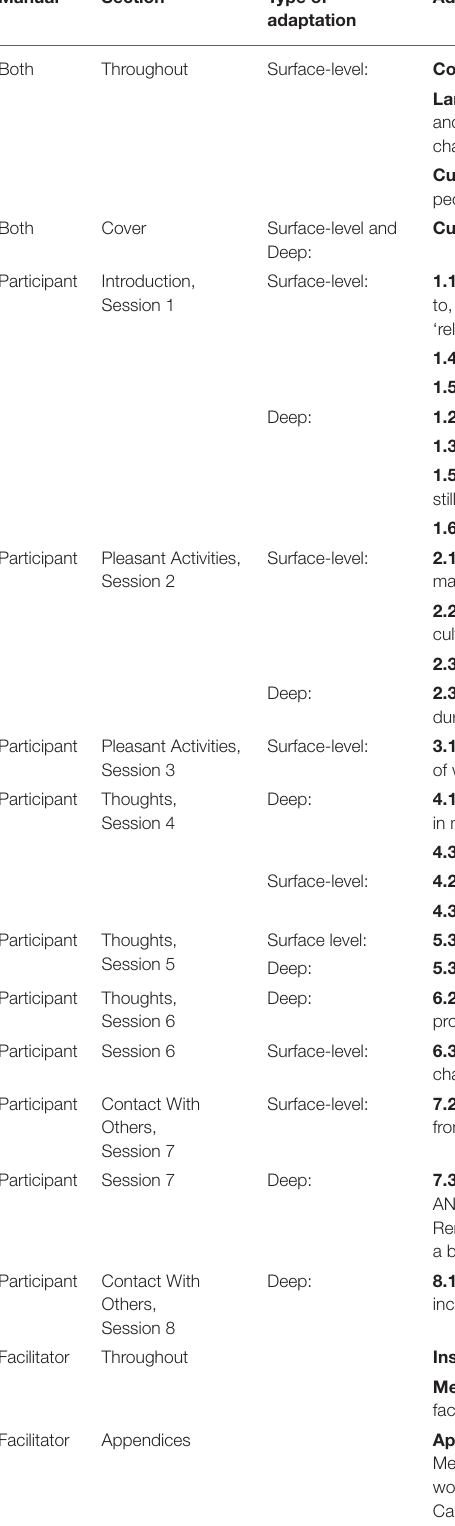
TABLE 2 | Adaptations. Manual Section Type of Both Throughout Surface-level: